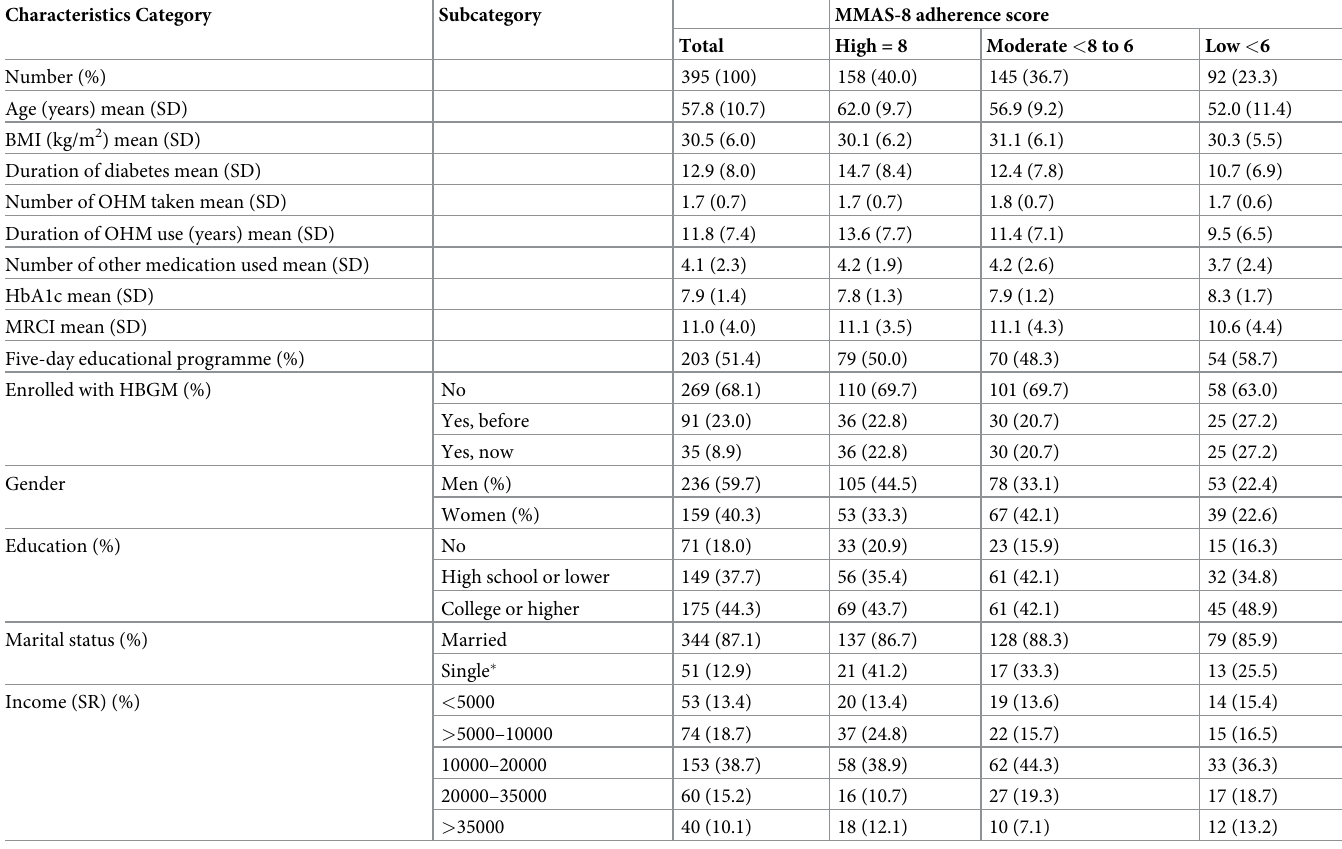
Table 1. Characteristics of participants in the cross sectional study n =